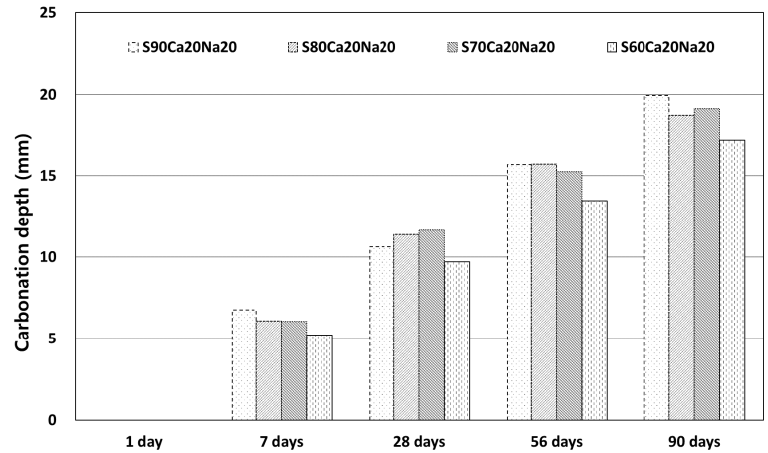
Figure 7. Carbon capture depth measurement result (exposure to high concentration CO 2 ).